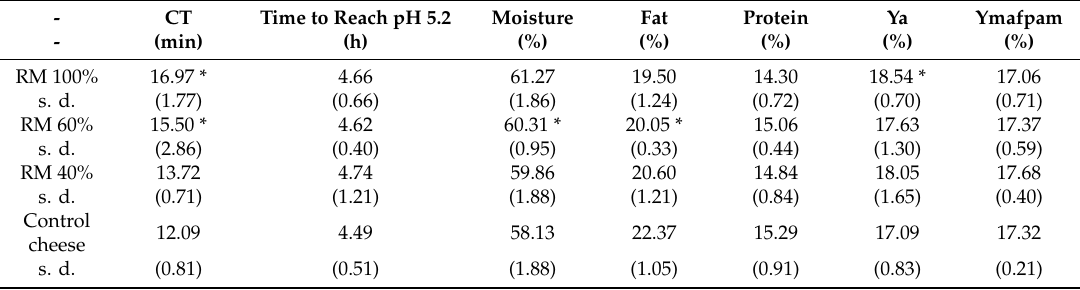
Table 3. Clotting time (CT) and fermentation time to pH 5.2 during processing. Actual (Ya), corrected (Ymafpam) cheese yield and gross composition of Crescenza-type cheeses produced with di ff erent concentrations of recombined milk (RM) and with 100% fresh milk (control cheese) were determined after 7 days of